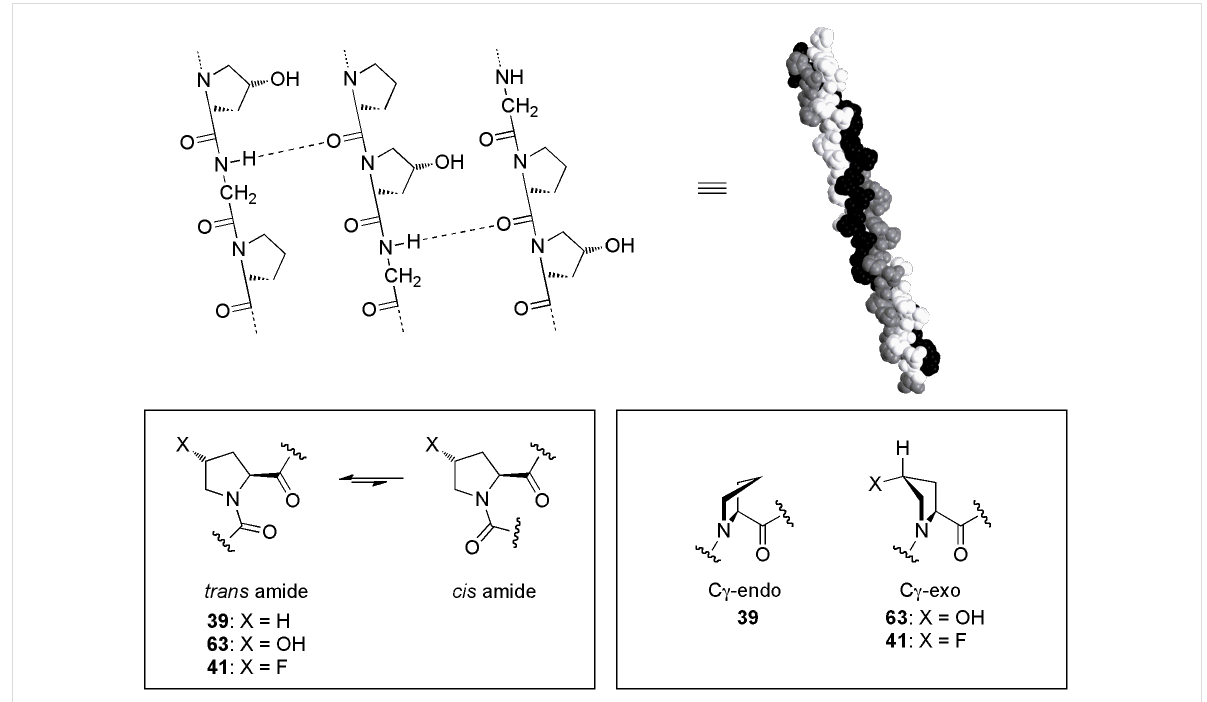
Figure 16: Collagen mimics of general formula (Pro-Yaa-Gly) 10 where Yaa is either 4( R )-hydroxyproline ( 63 ) or 4( R )-fluoroproline ( 41 ). The fluorin- ated isomer is more stable, due to an increased preference for the trans amide bond and the C γ - exo pyrrolidine ring pucker. The illustrated collagen triple helix structure is from PDB code 1CAG [45].